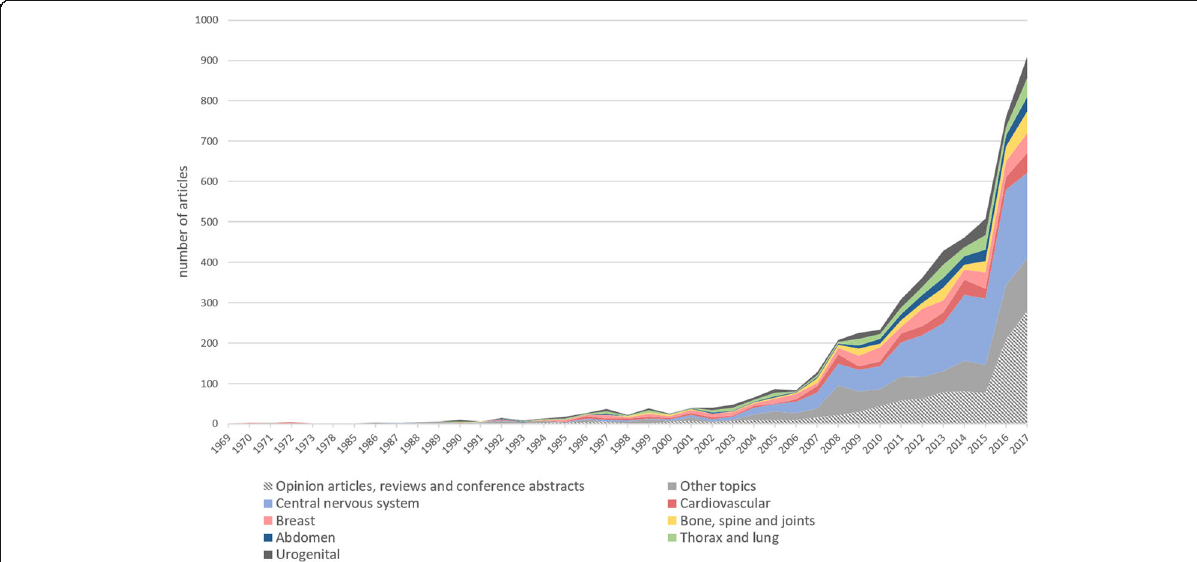
Fig. 5 Number of publications indexed on EMBASE obtained using the search query ( ‘ artificial intelligence ’ /exp. OR ‘ artificial intelligence ’ OR ‘ machine learning ’ /exp. OR ‘ machine learning ’ OR ‘ deep learning ’ /exp. OR ‘ deep learning ’ ) AND ( ‘ radiology ’ OR ‘ diagnostic imaging ’ ). EMBASE was accessed on April 24, 2018. For each year, the number of publications was subdivided separating opinion articles, reviews and conference abstracts from original articles in seven main subgroups considering subspecialty or body part. Other fields of medical imaging different from those listed above are grouped under the “ other topics ” label (e.g. dermatology, ophthalmology, head and neck,